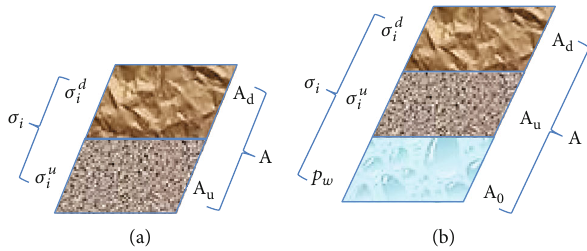
Figure 2: Schematic diagram of the extended damage models for rock: (a) rock is composed of undamaged area and damaged area [18] and (b) rock is composed of undamaged area, damaged area, and voids [21]. Table 1: Rock mechanical parameters of fractured limestone [20, 24].